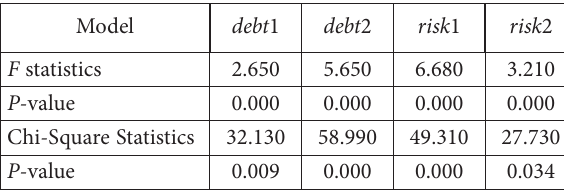
Table 2. F -test and Hausman test of models